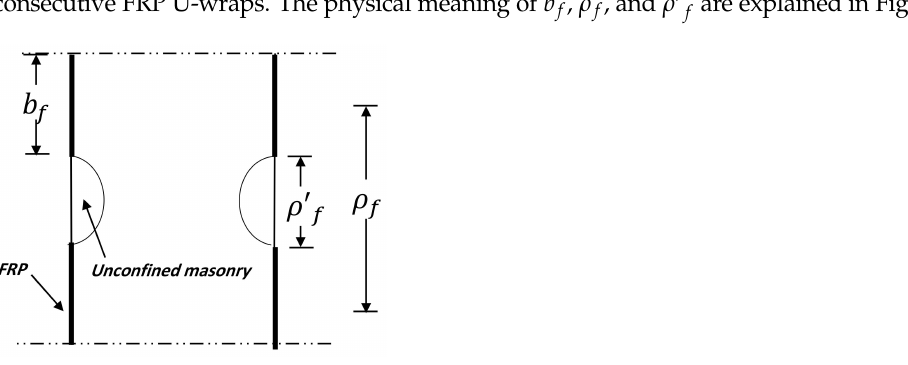
Figure 1. Front view of prismatic masonry member confined with discontinuous FRP